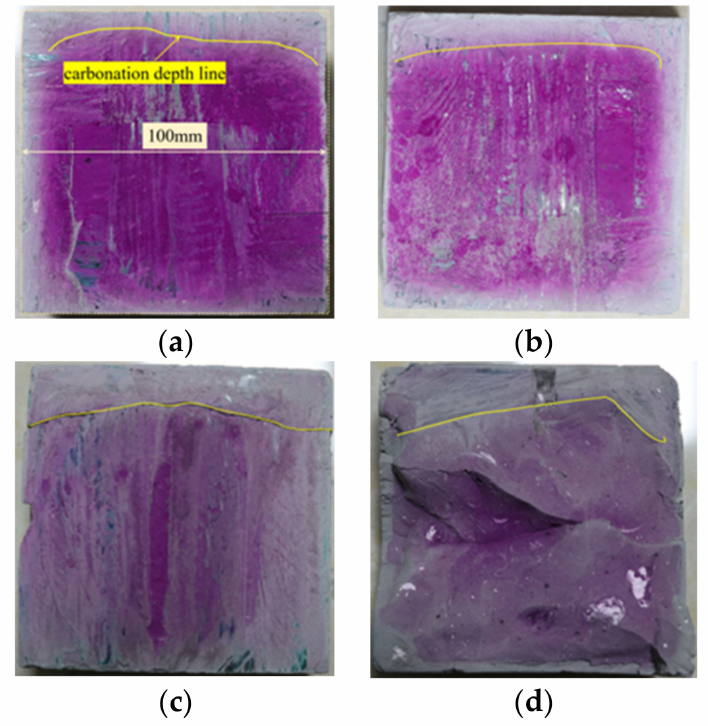
Figure 3. Phenolphthalein test diagram of carbonation depth in PSK samples that had been subjected to differing amounts of carbonation curing—( a ) 3 d ( b ) 7 d ( c ) 14 d and ( d ) 28